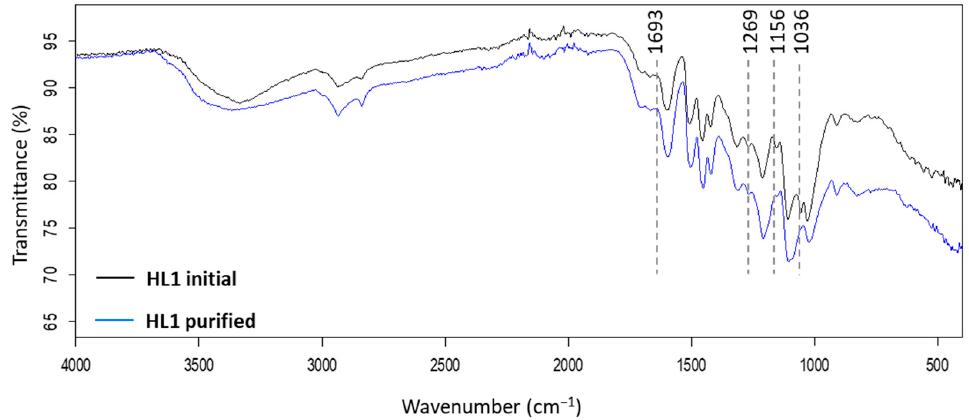
Figure 5. FTIR spectra of the initial HL1 and purified fraction after the alkaline hydrolysis-acid precipitation using 0.1 M NaOH, initial W lign = 0.03, and T = 25 ◦ C. Highlighted bands correspond precipitation using 0.1 M NaOH, initial W lign = 0.03, and T = 25 °C. Highlighted bands correspond to to polysaccharides.